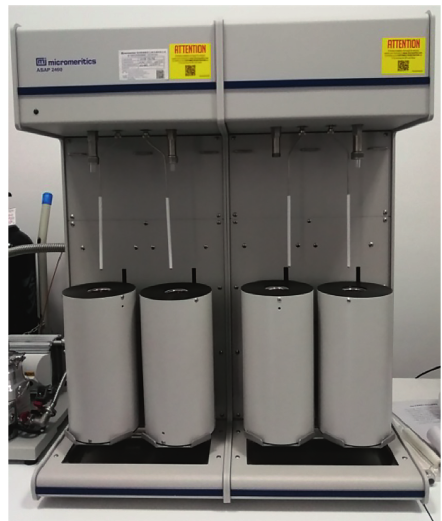
Figure 2: ASAP 2460 multistation type-specific surface area and porosity